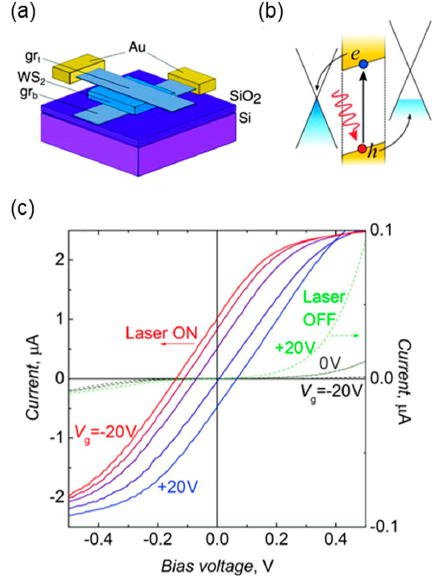
Figure 5. Photodetection device based 2D vdW heterostructure composed of graphene/WS 2 /graphene: ( a ) Schematic illustration; ( b ) band alignment; and ( c ) photoresponse characteristics as a function of the gate voltages. Reproduced with permission from [37]. Copyright Science, 2013.